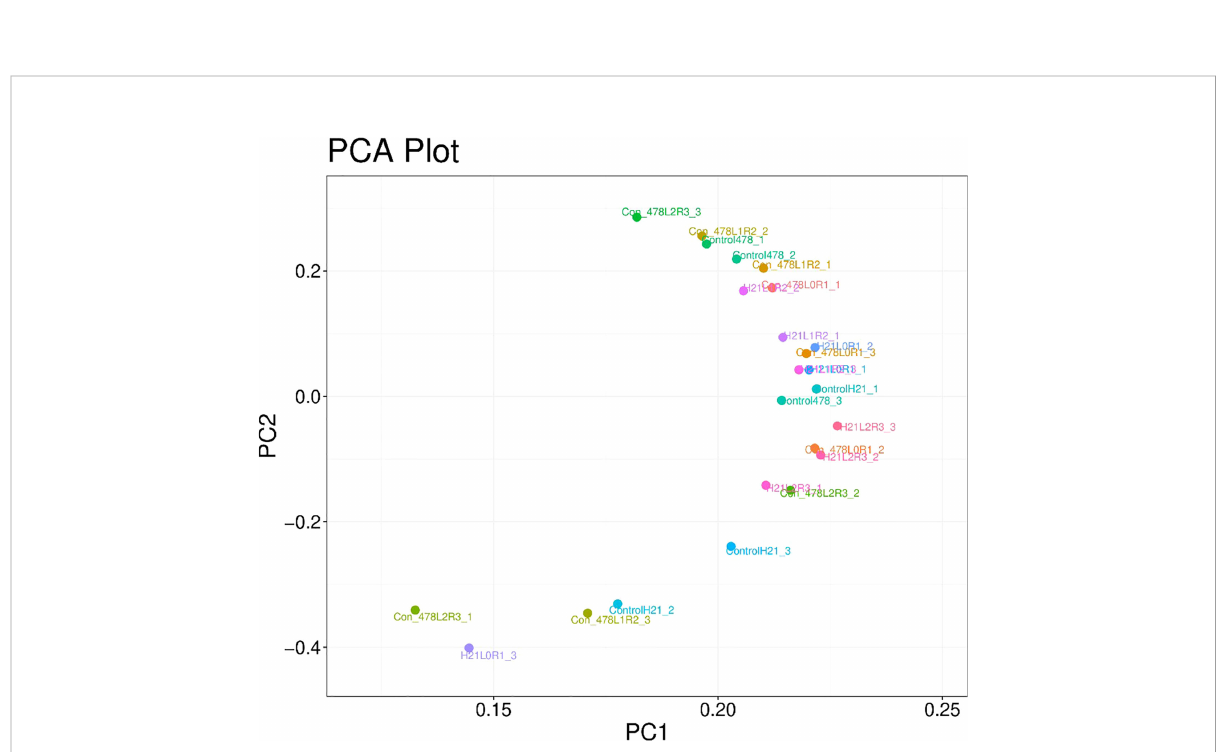
FIGURE 9 Categorization of different maize genotypes for drought tolerance and sensitivity. Principal component analysis of maize varieties based on different parameters visible in the form of colored spots with different